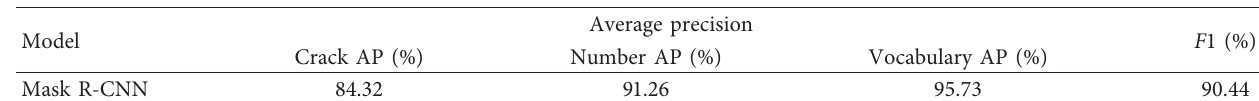
Figure 8: Mask R-CNN results. Table 3: Detection results of Mask